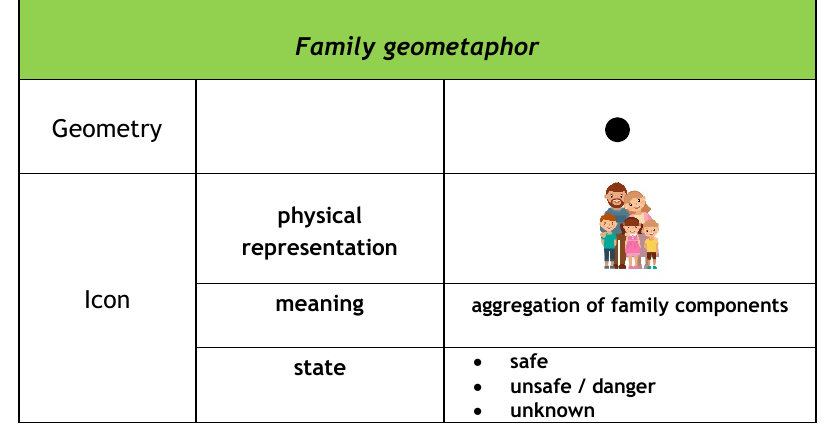
Figure 4. The Family geometaphor.